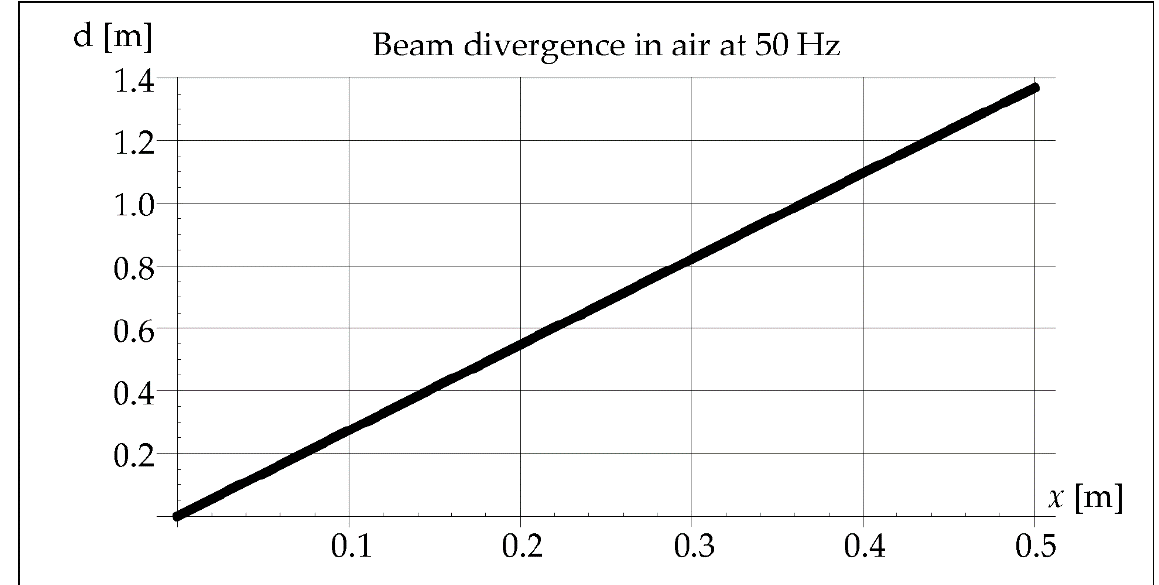
Figure 5. Beam divergence in air at 50 Hz. in steel than in the air, as shown in Figure 6.